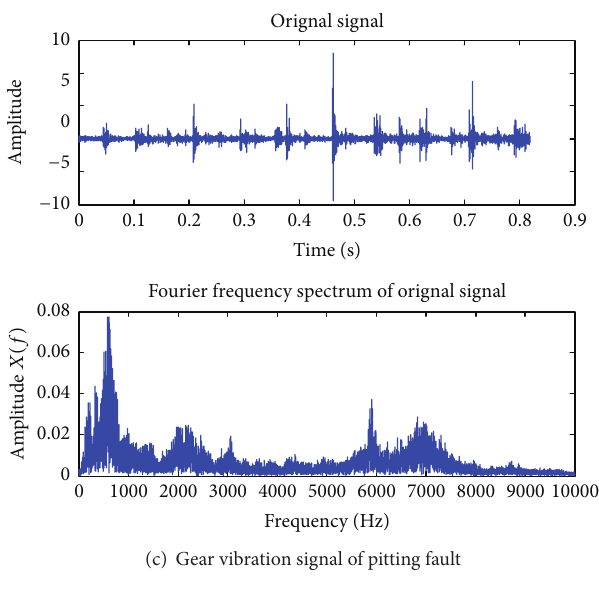
Figure 4: Gear vibration